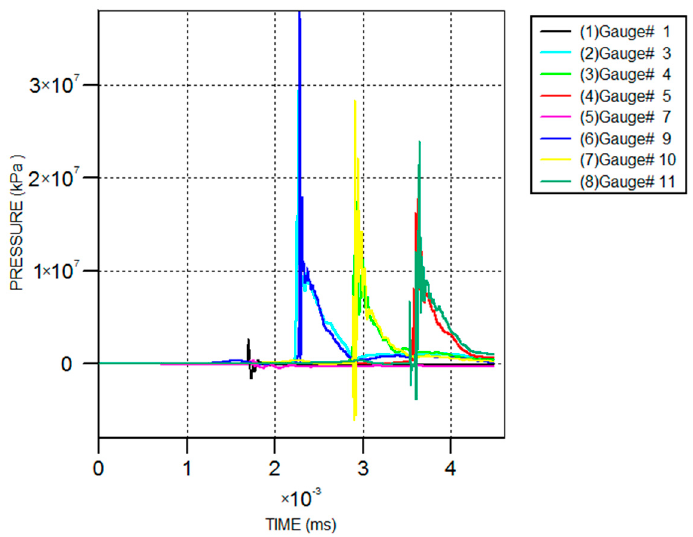
Figure 7. The pressure ‐ time curves of special points.